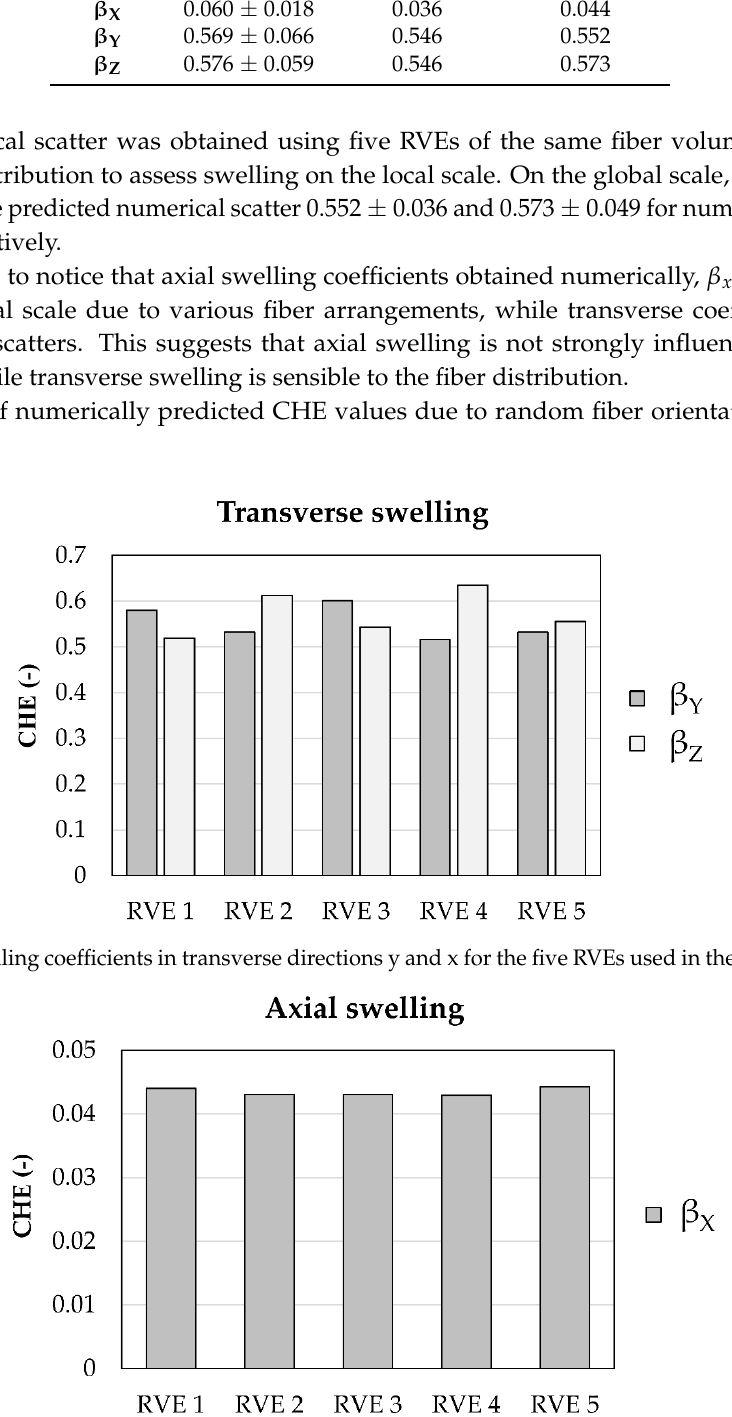
Figure 9. Swelling coefficient in axial direction, z, for the five RVEs used in the simulations.